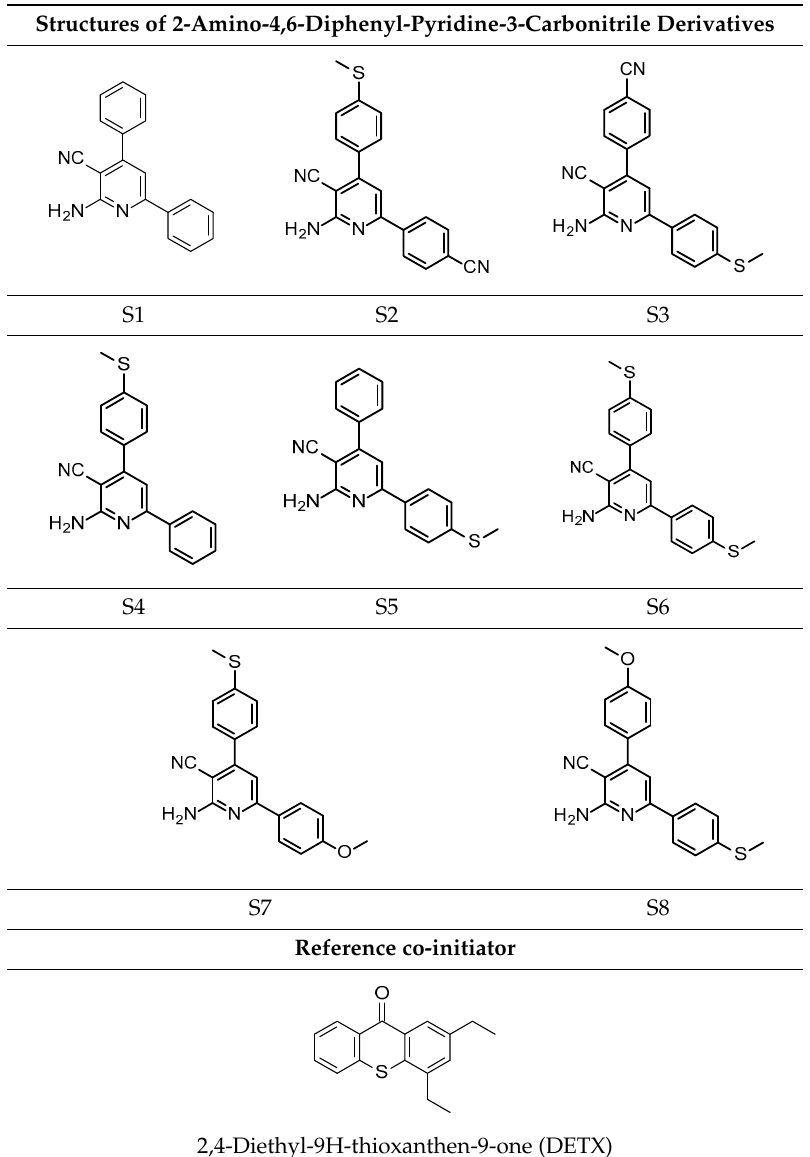
Table 6. Structures of investigated photosensitizers for photopolymerization processes.